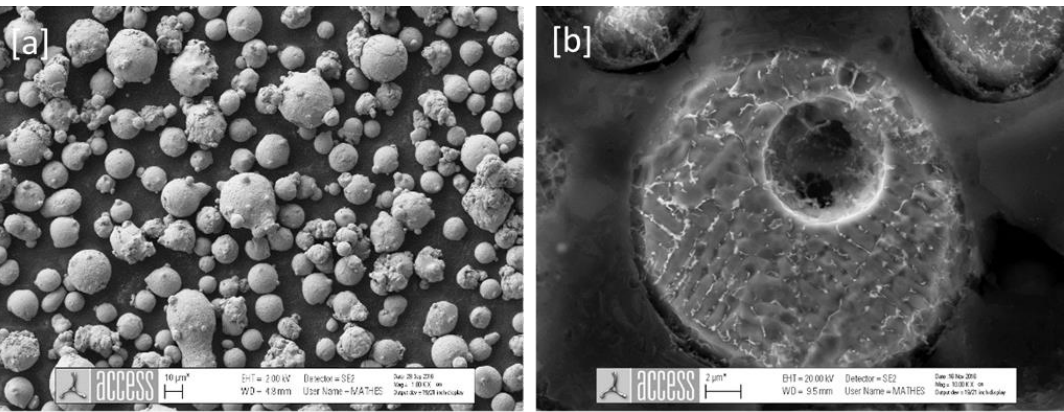
Figure 1. SEM micrographs: ( a ) morphology of the gas atomized G-NiCu30Nb (DIN 2.4365) powder; ( b ) etched powder particle revealing dendrite structures.